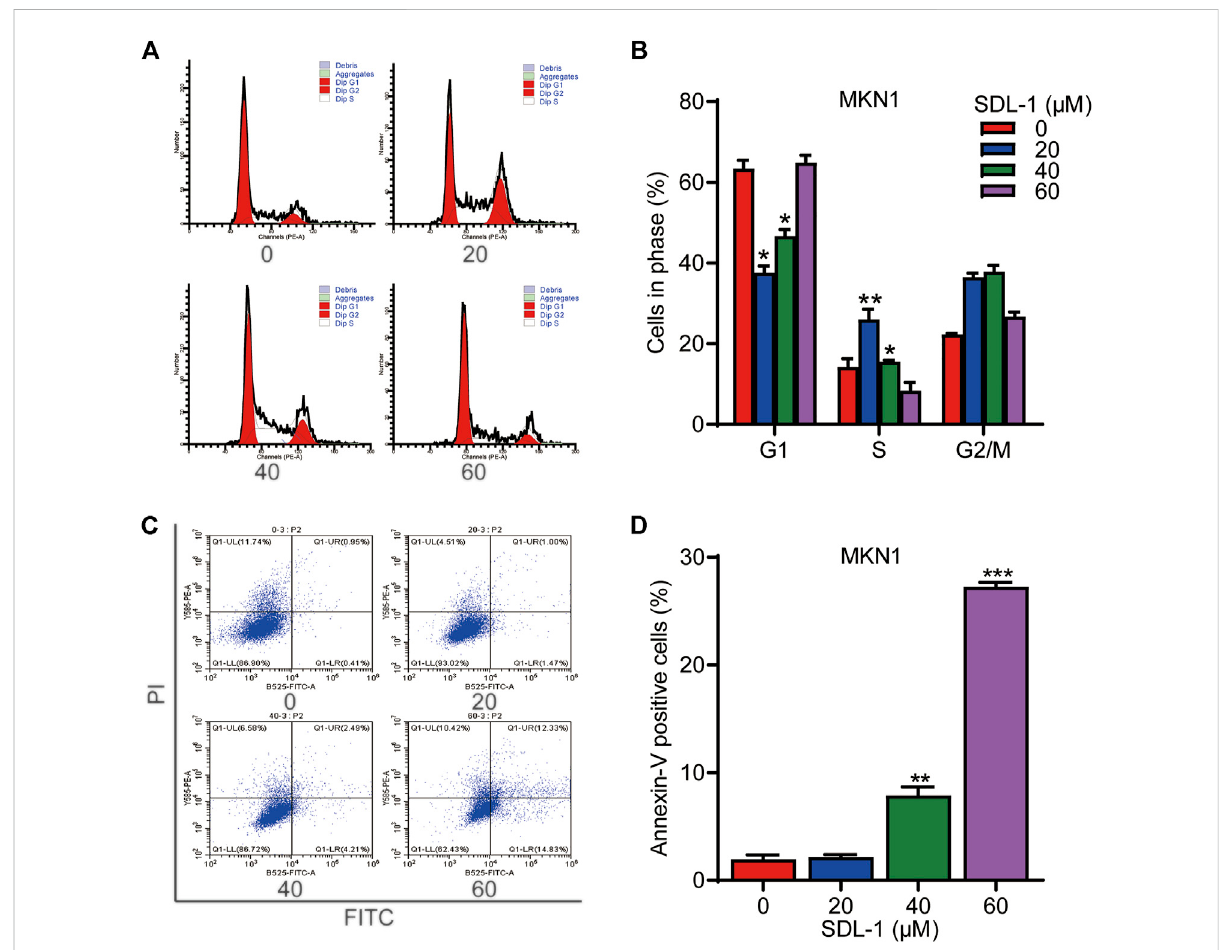
FIGURE 4 SDL-1 can block cell cycle of gastric cancer cell and induces apoptosis in vitro . (A,B) SDL-1 was treated for 24 h and fi xed, followed by the propidium iodide/RNase analysis. (C,D) MKN1 cells were treated with SDL-1 at the indicated concentrations for 48 h, followed by the detection of apoptosis by FITC-Annexin V assay. Results are presented as mean ± SD. (* p < 0.05; ** p < 0.01, *** p <